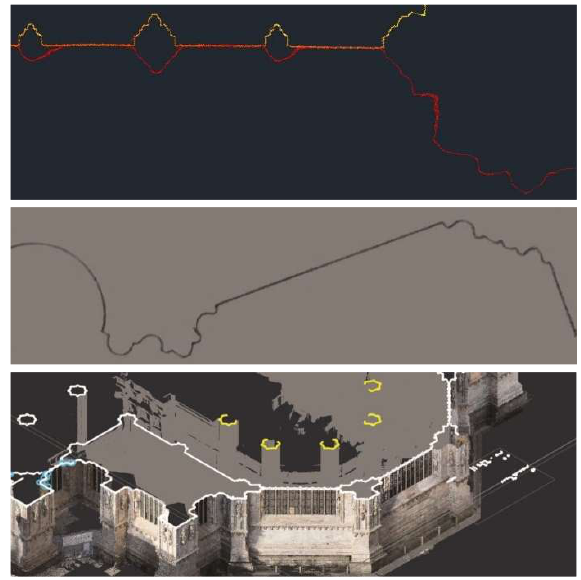
Figure 7. Plotting of the photogrammetric (red) and laser scanning (yellow) dense cloud (top image). High resolution photogrammetric profile obtained by later integration (centre). The point cloud used for the plan restitution